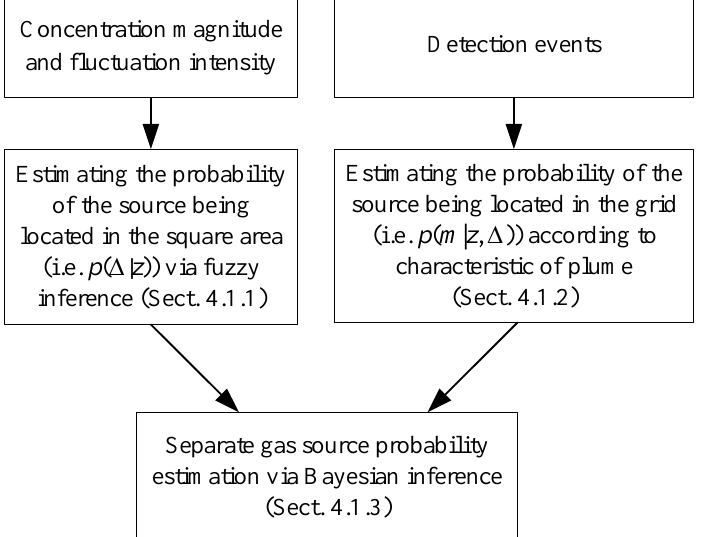
Figure 3. The flowchart of the separate gas source probability